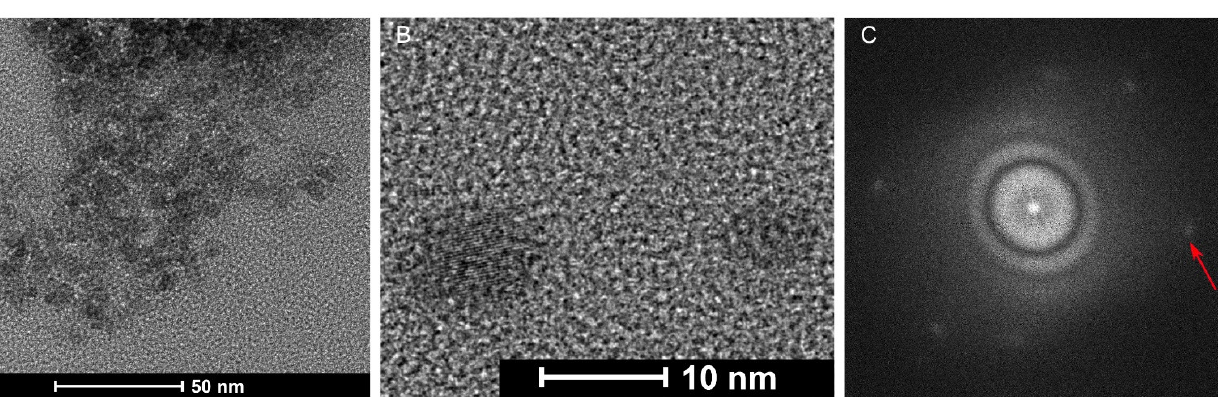
Figure 3. Hydrodynamic diameters of the carbon dots in water suspension according to the Zetasizer ( A – D ). gCD(in), gCD retained in the dialysis membranes; gCD(out), gCD) eluate; sCD(in), sCSs retained and sCD(out), sCD eluate from the dialysis membranes. Apparent ζ potential distri- butions of the retained and eluate gCDs and sCDs ( E – H ). The CDs were prepared using glucose or saccharose passivated with bPEI 2 KDa.